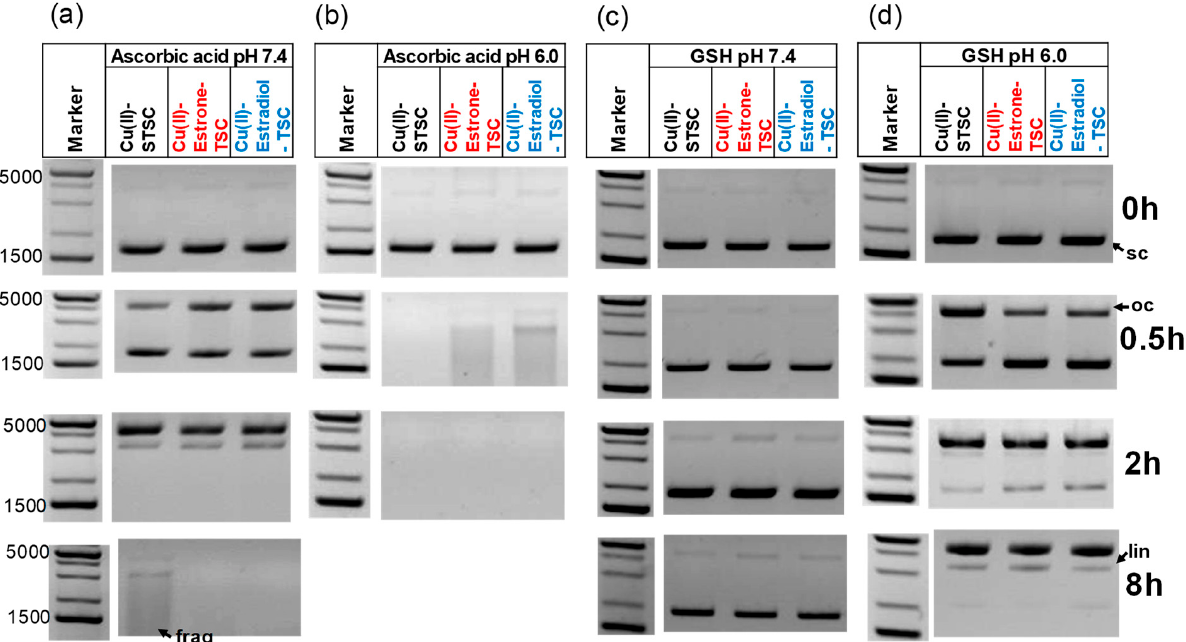
Figure 9. Representative DNA cleavage activity of the Cu(II)-TSC complexes analyzed by 1% ( w / v ) agarose gel electrophoresis in the presence of 1 mM ascorbic acid ( a ) at pH 7.4 and ( b ) at pH 6; or in the presence of 1 mM GSH ( c ) at pH 7.4 and ( d ) at pH 6.0. The reaction mixtures contained 100 ng pUC119 Δ H+N ‐ N6 plasmid DNA. ( c L = 20 μ M; c Cu (II) = 18 μ M; (10 mM HEPES); incubation time at